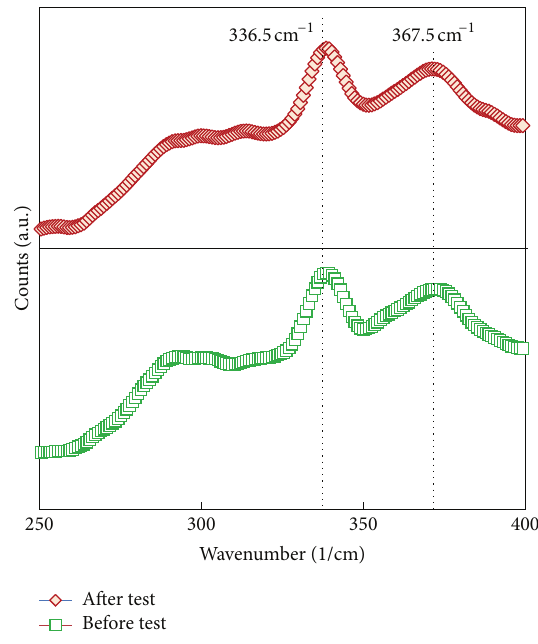
Figure 6: (a) Raman spectra of CZTS film before and after test in europium nitrate solution (b) Raman spectra of CZTS film before and after test in oxalic acid aqueous solution. No significant change in Raman spectra was found after electrochemical test in formaldehyde, sodium sulfite, or sodium nitrite